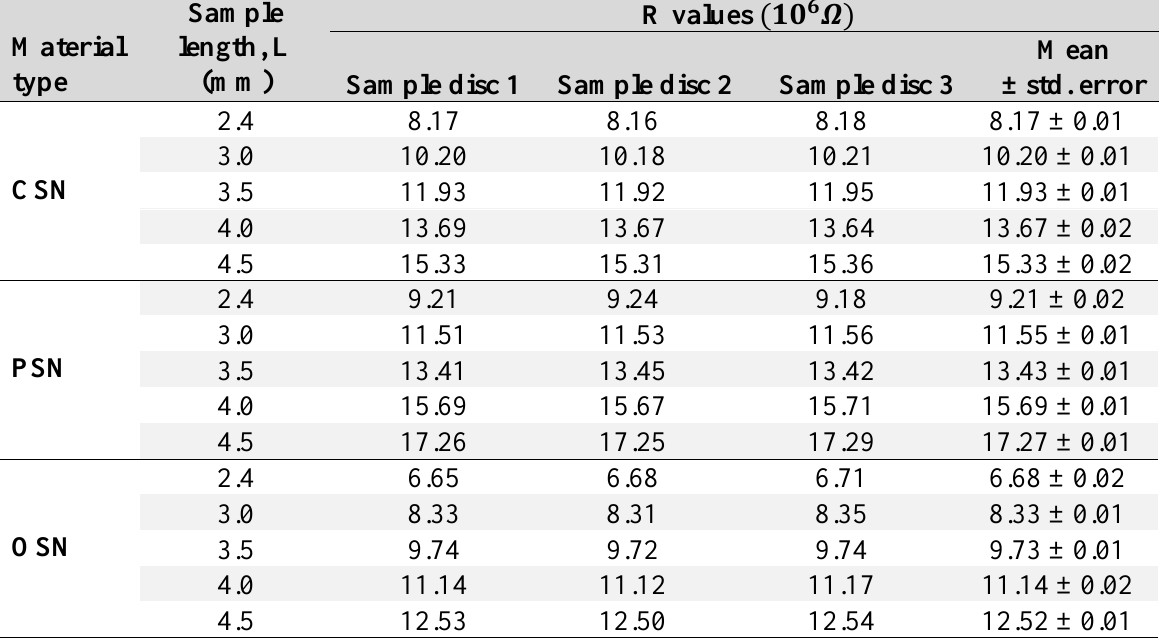
Table 2. Outline of the determined experimental results for the material samples.